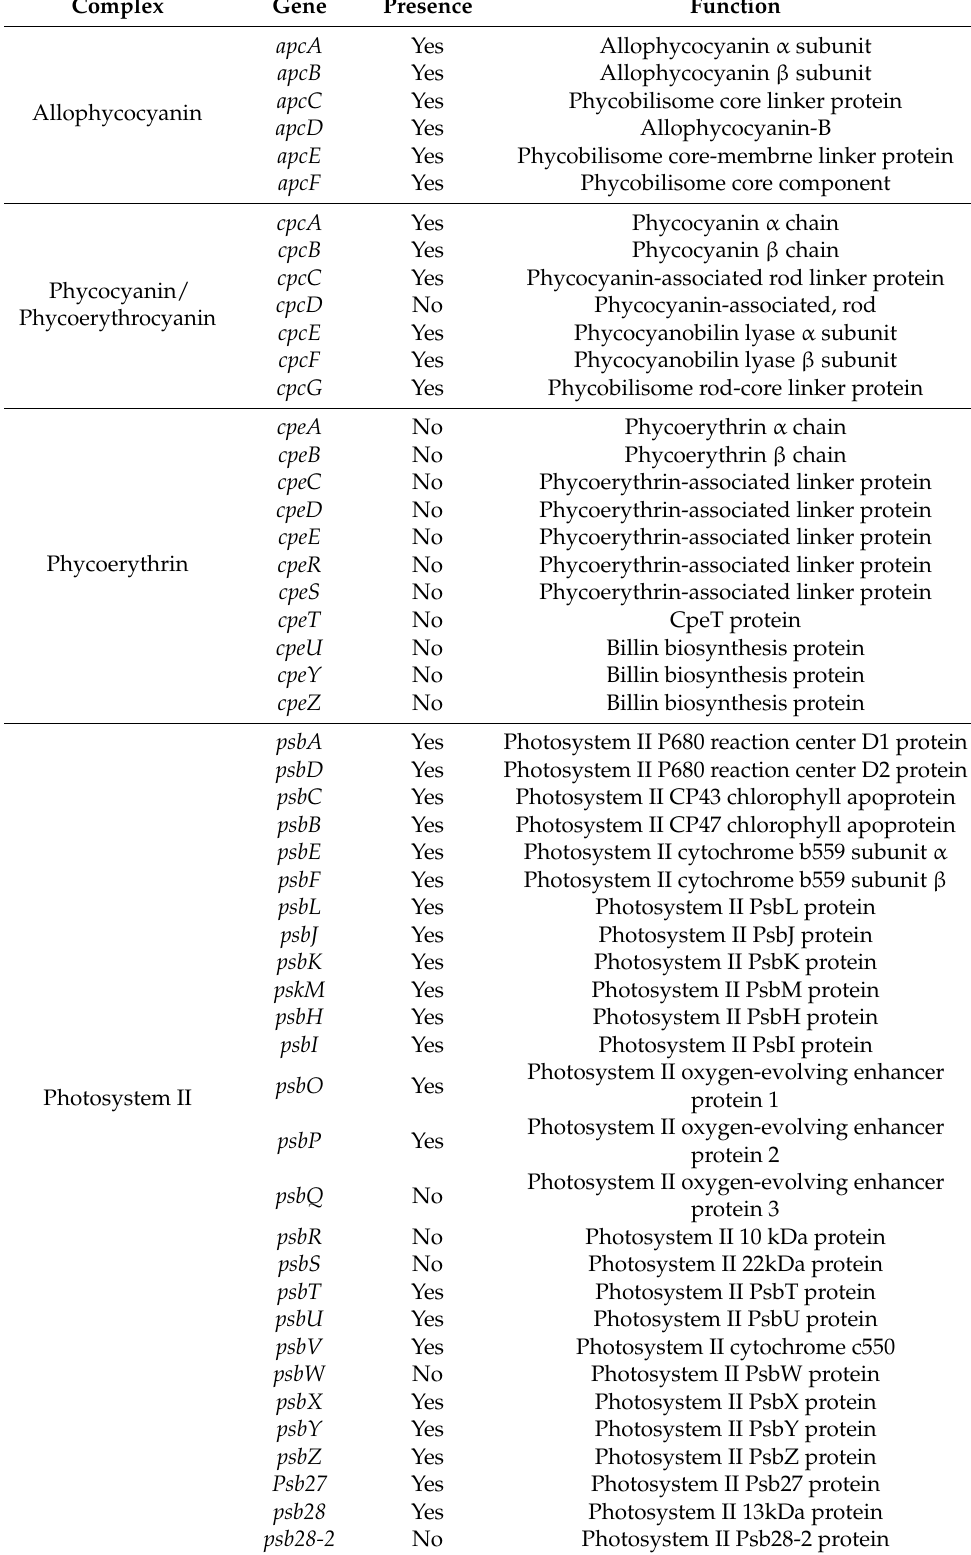
Table 4. Phycobilisome, photosynthesis, and respiratory machinery genes present in the P. pseudo- priestleyi MAG generated with GhostKoala